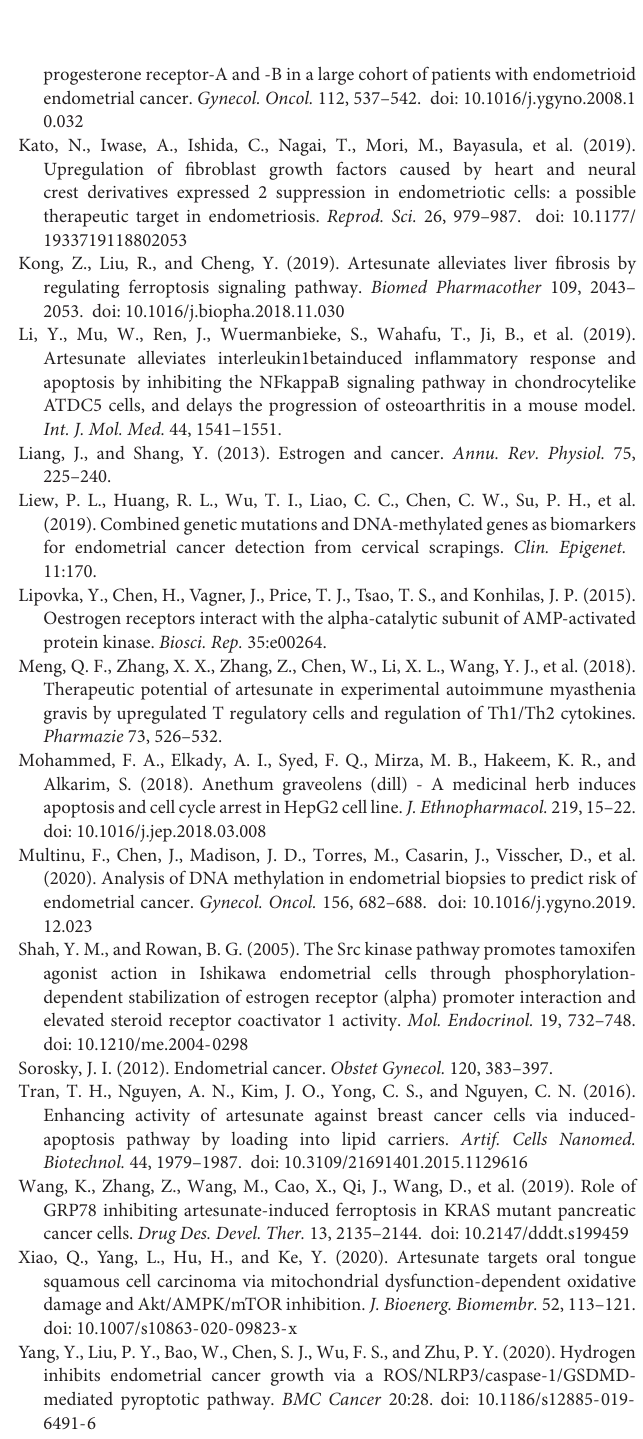
Supplementary Figure 2 | ART inhibited the proliferation of ER- α -positive cells via the HAND2 dependent pathway. The ER- α -positive Ishikawa cells were treated with (A) 30 µ g/mL of ART or (B) control for 4 days. The ER- α -positive HEC-1-A cells were treated with (C) 30 µ g/mL of ART or (D) control for 4 days. The ER- α -negative JEC cells were treated with (E) 30 µ g/mL of ART or (F) control for 4 days. The western blot and qRT-PCR analysis were performed for the expression of ER- α , p-LKB1, p-AMPK, p-mTOR, and HAND2 in these cells after different